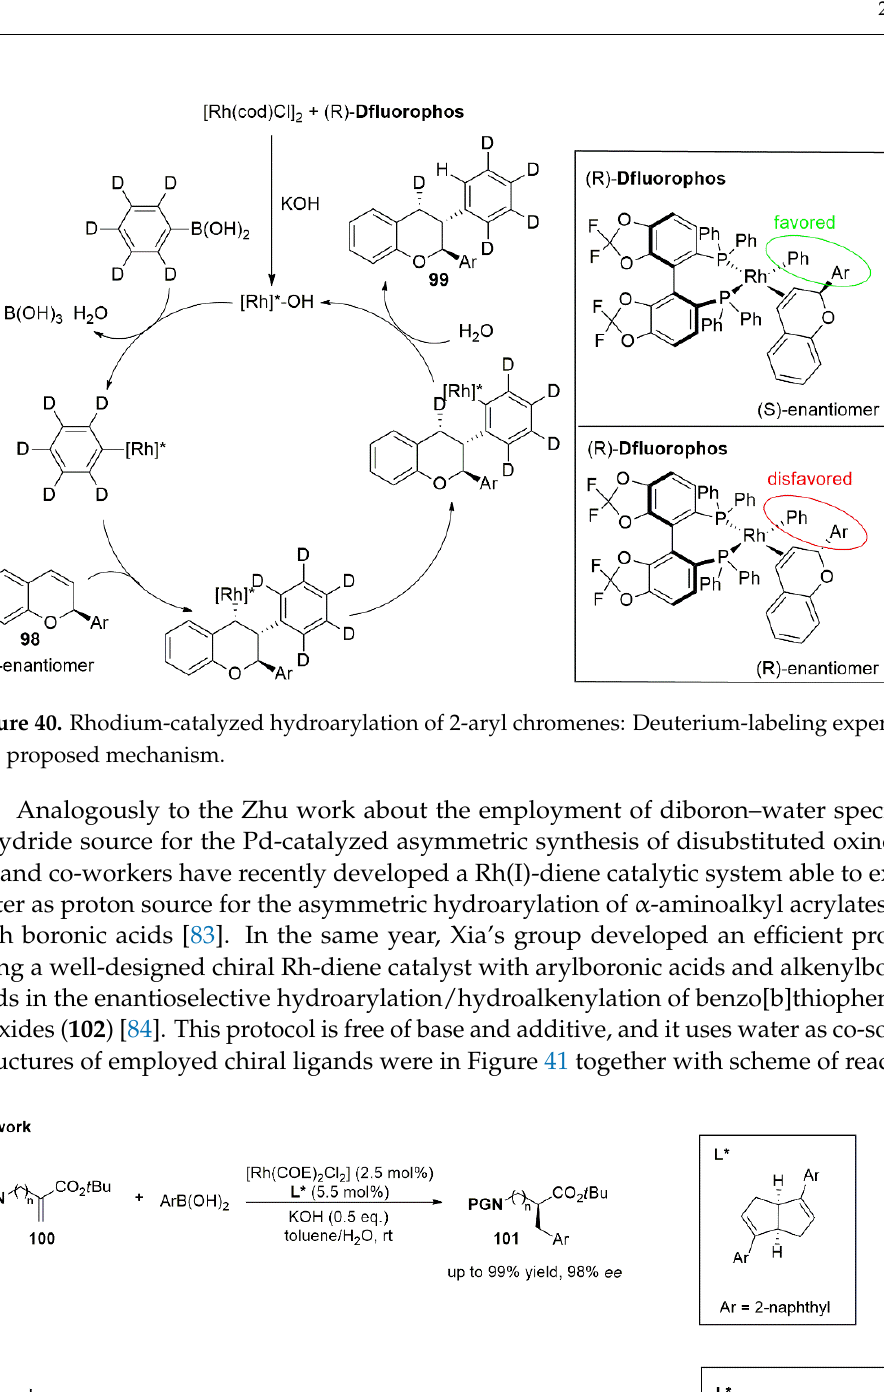
24 of 29 Figure 39 . Asymmetric hydroarylation of divinylphosphine oxides ( 94 ) and aryl boroxines ( 95 ). Cat- alyst complex: Rh/(R)-DTBM-segphos. In the same year, Wang and co-workers reported an example of Rh-catalyzed asym-